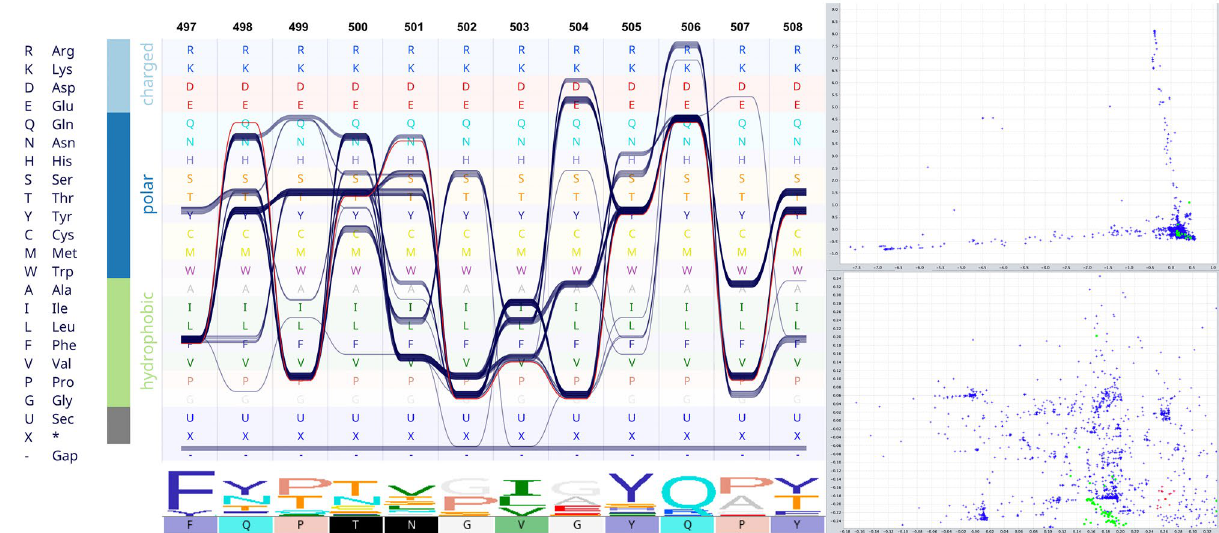
Figure 2. Combination of sequence bundle plot with sequence logo and correspondence scattered plot. The top left panel was initiated with different amino acids sorted by their chemical properties. Additionally, the top panel displays every sequence in the alignment as an individual continuous line, whose shapes correspond to the residues of that sequence. Multiple sequences that have the same residue are stacked on top of each other, thereby forming a thick bundle (conserved site). The sequence logo of the alignment section is also presented below the bundles and is followed by a color-coded sequence of Sgp SARS-CoV-2 . The top left section shows the correspondence analysis scattered plot. Sequences are shown as green circles and sites as blue crosses. The Sgp SARS-CoV-2 sequence and nearby sites are selected (red colors). The selected sites (shown in red color) are mirrored in the sequence of Sgp SARS-CoV-2 at the lower panel (black boxes). Residues Thr500 and Asn501 are identified as significantly associated with Sgp SARS-CoV-2 . The lower left is a zoom-in view of the selected site.